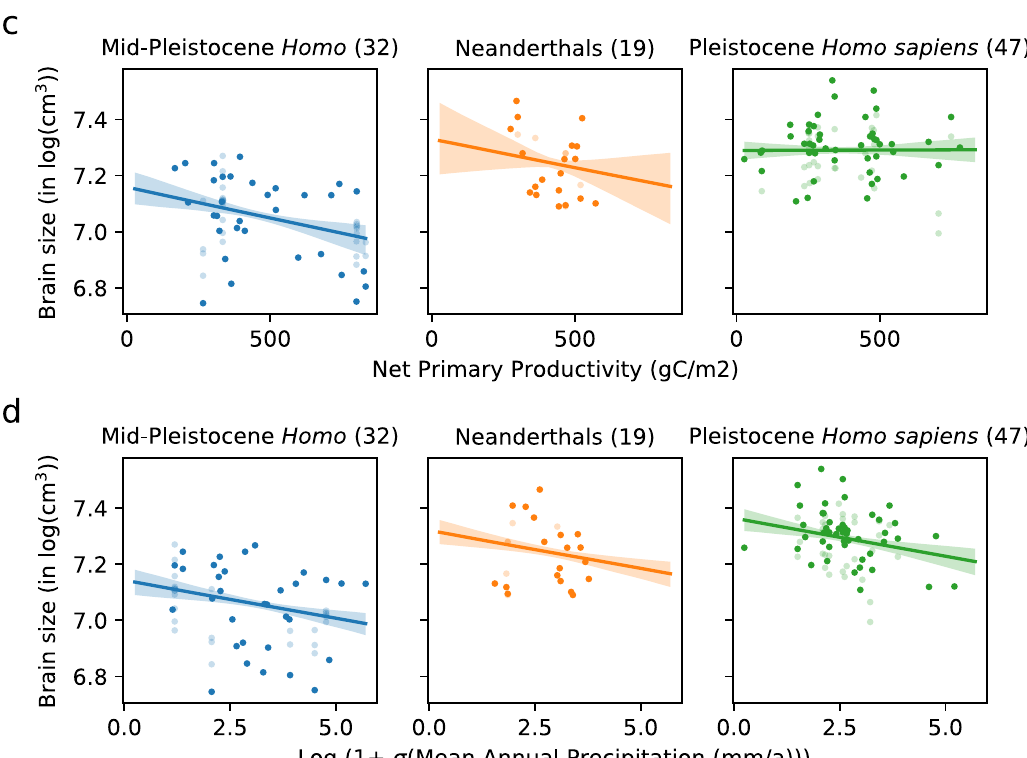
Fig. 3 Environmental variables associated with body and brain size variation in later Homo . The relationships of environmental variables showing the strongest statistical support for body size among the fossil data are a mean annual temperature (LM-TC) and b temperature of the coldest quarter (LM- TC); for brain size, these are: c net primary productivity (LM-T*C) and d long-term variability of annual precipitation (LM-TC). The shaded band corresponds to the 95 percentile range (2.5 – 97.5%) of all linear regression lines that have been calculated for the 1000 randomized and thinned samples with the thick line in the center corresponding to the median (50 percentile). Each semi-transparent point represents a single fossil record, whereas the opaque points represent a record from a randomly thinned sub-sample. Numbers in brackets indicate the number of fossils used in thinned sub-samples. See Tables 2 and 3 for the size of these effects. Source data are provided as a Source data fi